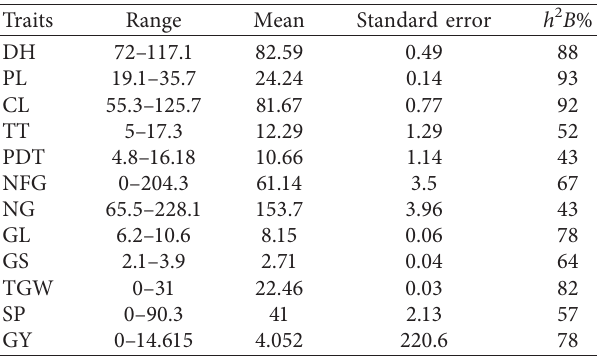
Table 7: Estimates of range, mean, standard error, and broad sense heritability.